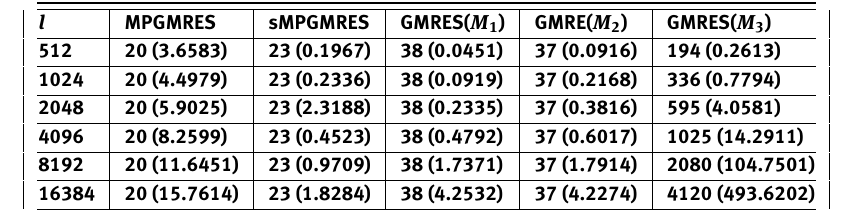
Table 6. The number of iterations and computing time in seconds (in brackets) for Example 4.2, when M 1 , M 2 and M 3 are used as